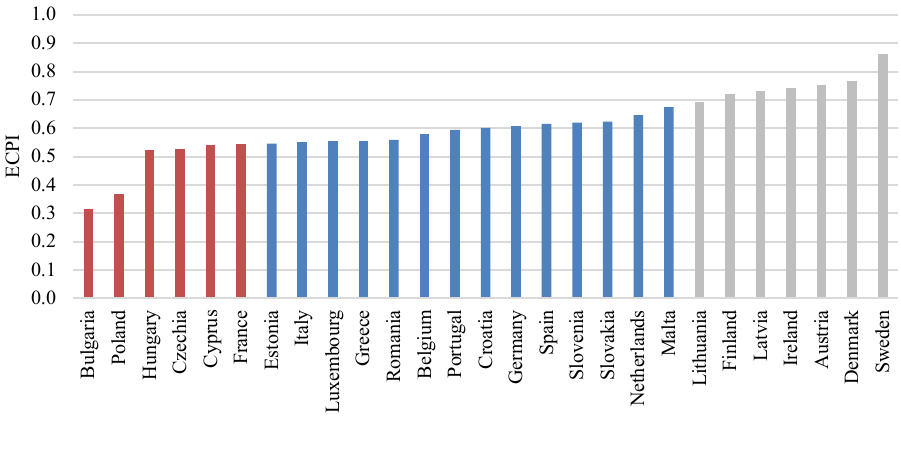
Fig. 7. ECPI values for different countries in 2017.